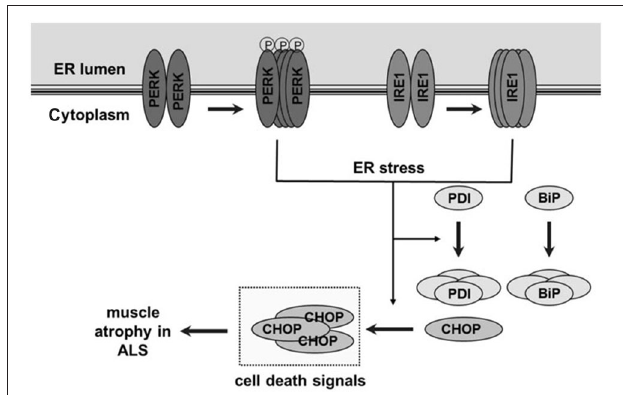
FIGURE 9 | Schematic figure showing unfolded protein response and endoplasmic reticulum (ER) stress pathway and its proposed role in skeletal muscle atrophy and weakness in ALS . In skeletal muscle of ALS-Tg mice, the G93A*SOD1 mutation leads to oxidative stress and protein misfolding. This leads to an age-dependent activation of ER stress sensors protein kinase RNA-activated-like ER kinase (PERK) and inositol-requiring kinase 1-alpha (IRE1 α ). Normally, these ER stress sensors physically interact with the ER chaperone immunoglobulin binding protein (Grp78/BiP) which suppresses their activation but accumulation of unfolded/misfolded proteins activates Grp78/BiP, including an upregulation of Grp78/BiP and PDI protein expression. Prolonged and severe ER stress can trigger apoptosis by ER stress-specific cell death signals, including C/EBP homologous protein (CHOP) and caspase-12, leading to muscle